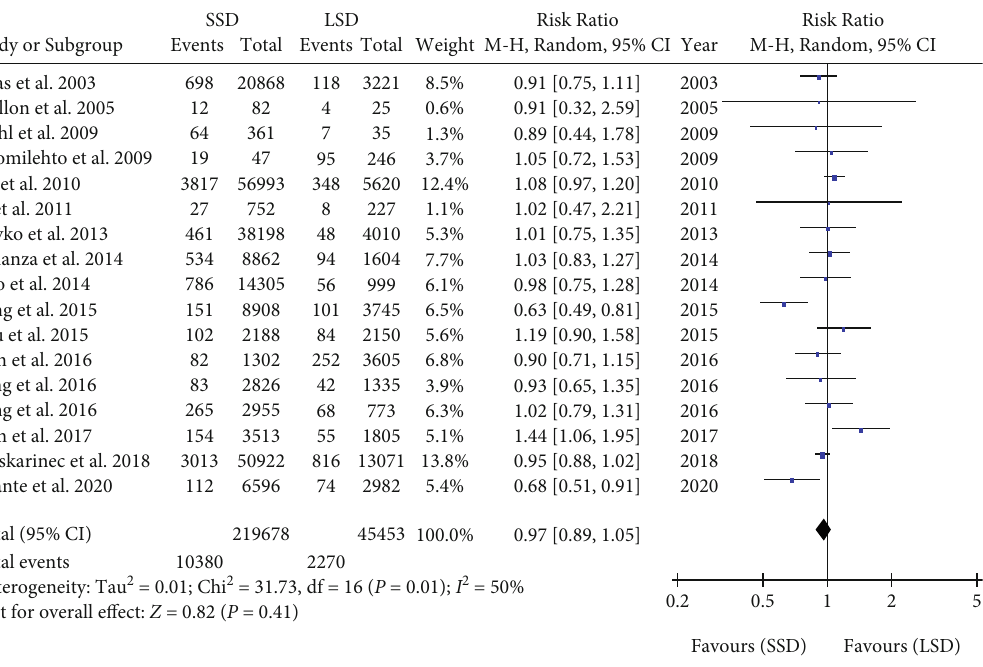
Figure 8: Pooled results of SSD versus LSD for T2DM.